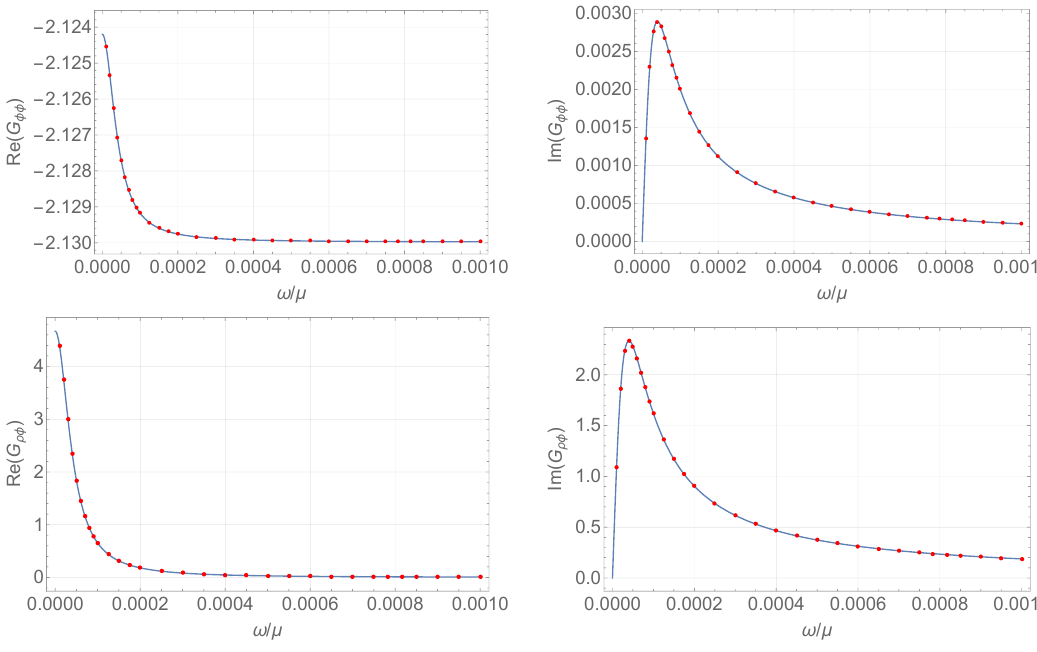
Figure 4 . Real and Imaginary part of the Green’s functions. Analytic results are displayed in dashed lines, while numerical results are show with black dots. Here φ s = 1 , q = 1 , µ = 1 , ζ ρ = 0 , ζ φ = 0 , λ φ = 1 , λ ρ = 1 / 4 , λ = − 3 / 4 and T/T c = 0 . 999957